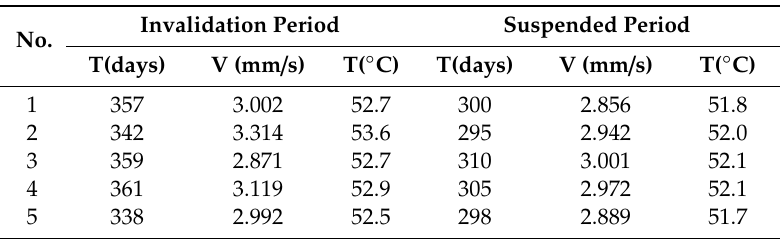
Table 6. Invalidation period and the suspended period for an OWT pitch.